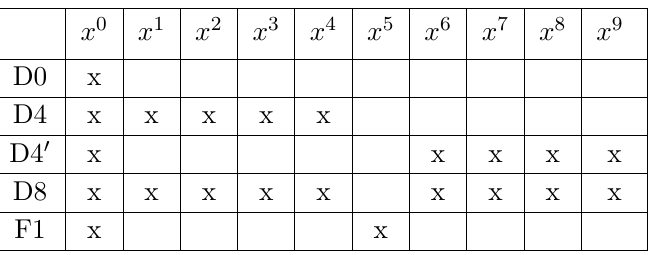
Table 2 . Brane set-up associated to our solution. Here x denotes the spacetime directions spanned by the various branes. x 0 corresponds to the time direction of the ten dimensional spacetime, x 1 , . . . , x 4 are the coordinates spanned by the CY 2 , x 5 is the direction where the F1-strings are stretched, and x 6 , x 7 , x 8 , x 9 are the coordinates where the SO (4) symmetry is